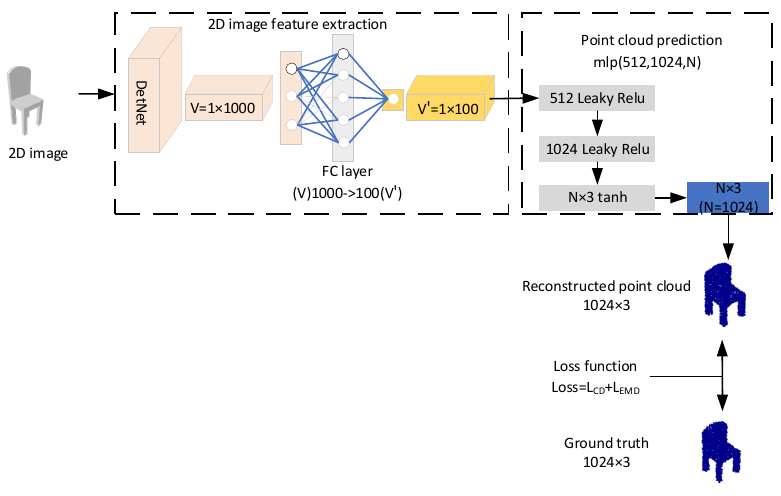
Figure 1. Architecture of 3D-SSRecNet.